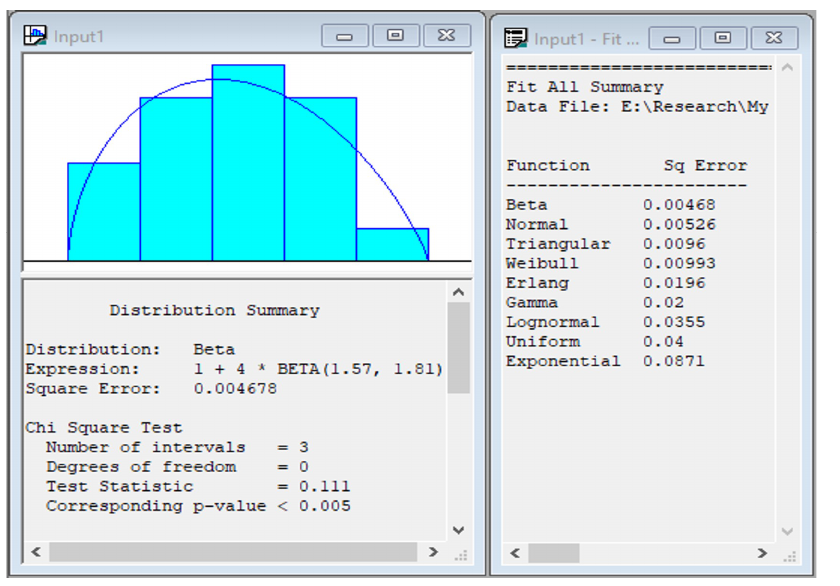
FIG. 4. DISTRIBUTION OF SERVED PATIENTS BY DOCTOR1